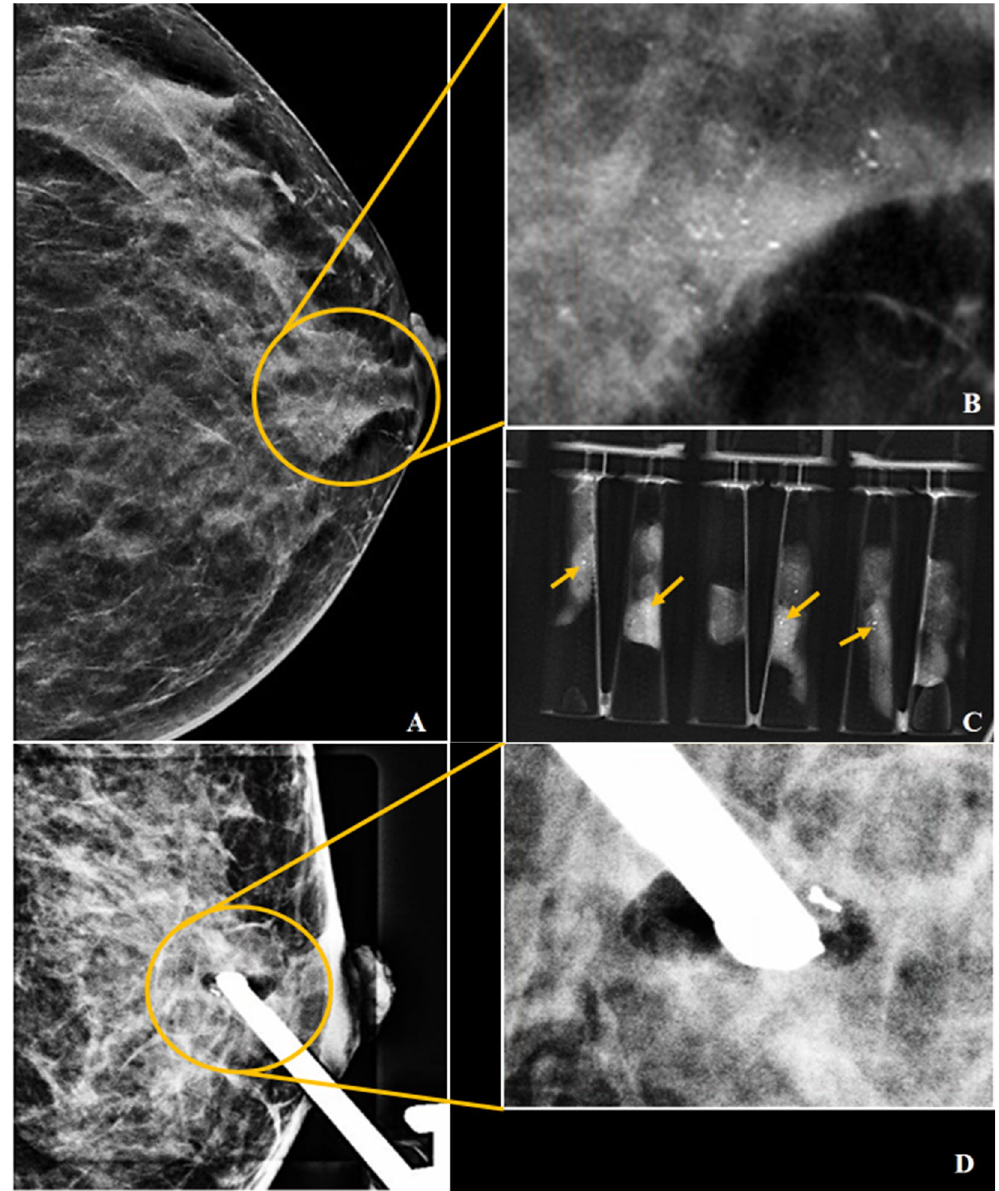
Figure 5. ( A–D ) Asymptomatic 42 year old lady who have strong family history of breast cancer came in for screening. The CC view of the left breast in C-view demonstrating fine pleomorphic calcifications with segmental distribution (yellow circle) in retroareolar region ( A ). Magnified view of area of calcifications as shown in ( B ). Specimens radiograph showing presence of microcalcifications within core tissues (yellow arrows in C ). Post-VABB shows no residual calcifications with post-biopsy change and biopsy marker in situ ( D ). VABB HPE revealed ADH and was upgraded to low-grade DCIS in the subsequent